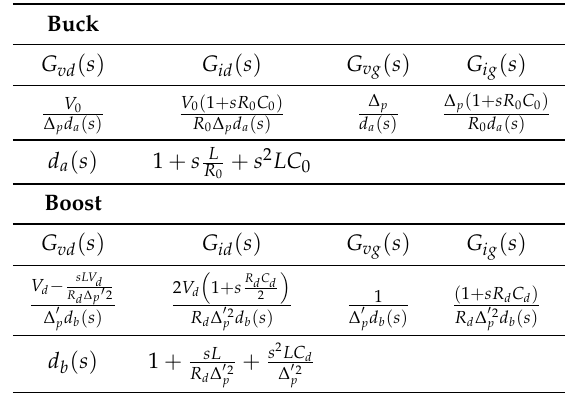
Table 3. Transfer functions (small-signal